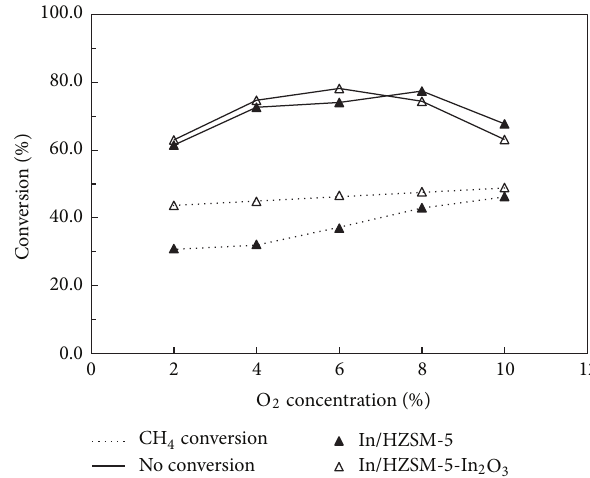
Figure 3: Effect of O 2 concentration on NO conversion to N 2 (solid line) and CH 4 conversion to CO 2 over In/HZSM-5 and In/HZSM- 5-In 2 O 3 at 400 ∘ C. Feed gas: 0.25% NO, 0.2% CH 4 , and the balance of He; GHSV = 3600 h −1 .